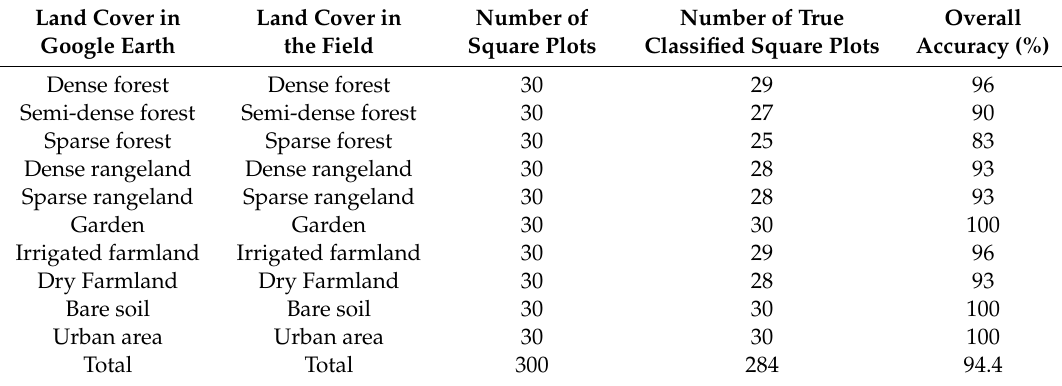
Table 3. Evaluating the accuracy of Google Earth data using 300 field plots.